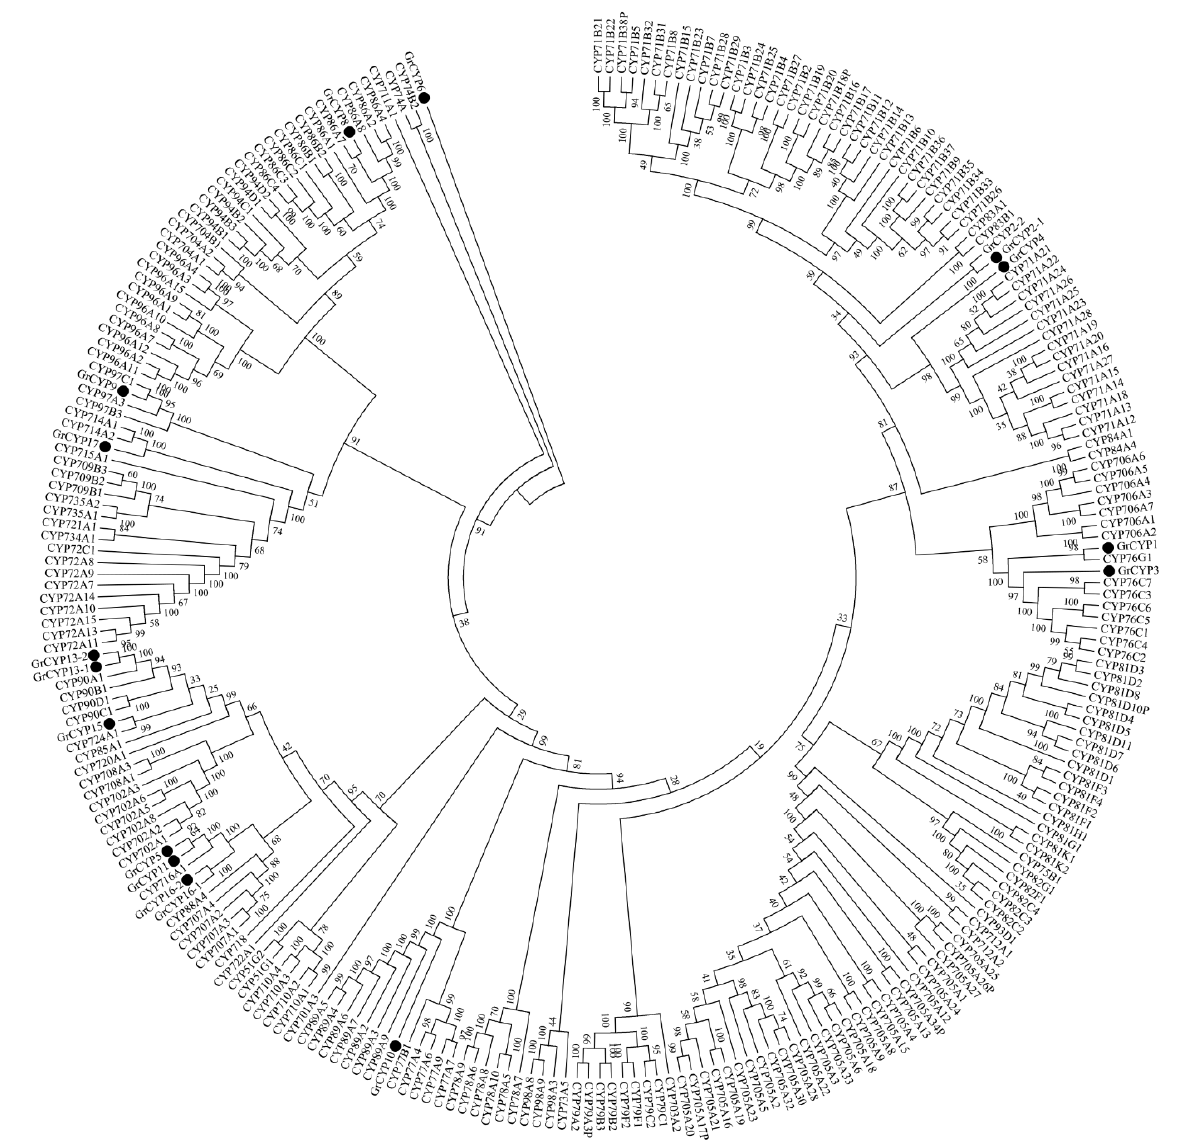
Figure 9. Phylogenetic analysis of CYP450s from G. rigescens. Amino acid sequences were aligned using the CLUSTALX2 program, and evolutionary distances were calculated using MEGA6 software with the Neighbor-Joining statistical method and Poisson model. The bootstrap replications were set to 1000. The GenBank accession numbers of the sequences are GrCYP1 (KP218047), GrCYP2-1 (KP218048), GrCYP2-2 (KP218049), GrCYP3 (KP218050), GrCYP4 (KP218051), GrCYP5 (KP325125), GrCYP6 (KP218052), GrCYP8 (KP325126), GrCYP9 (KP218053), GrCYP450-10 (KJ829649), GrCYP11 (KP218054), GrCYP13-1 (KP218055), GrCYP13-2 (KP218056), GrCYP15 (KJ829650), GrCYP16-1 (KP218057), GrCYP16-2 (KP218058), and GrCYP17 (KF941188). The sequences